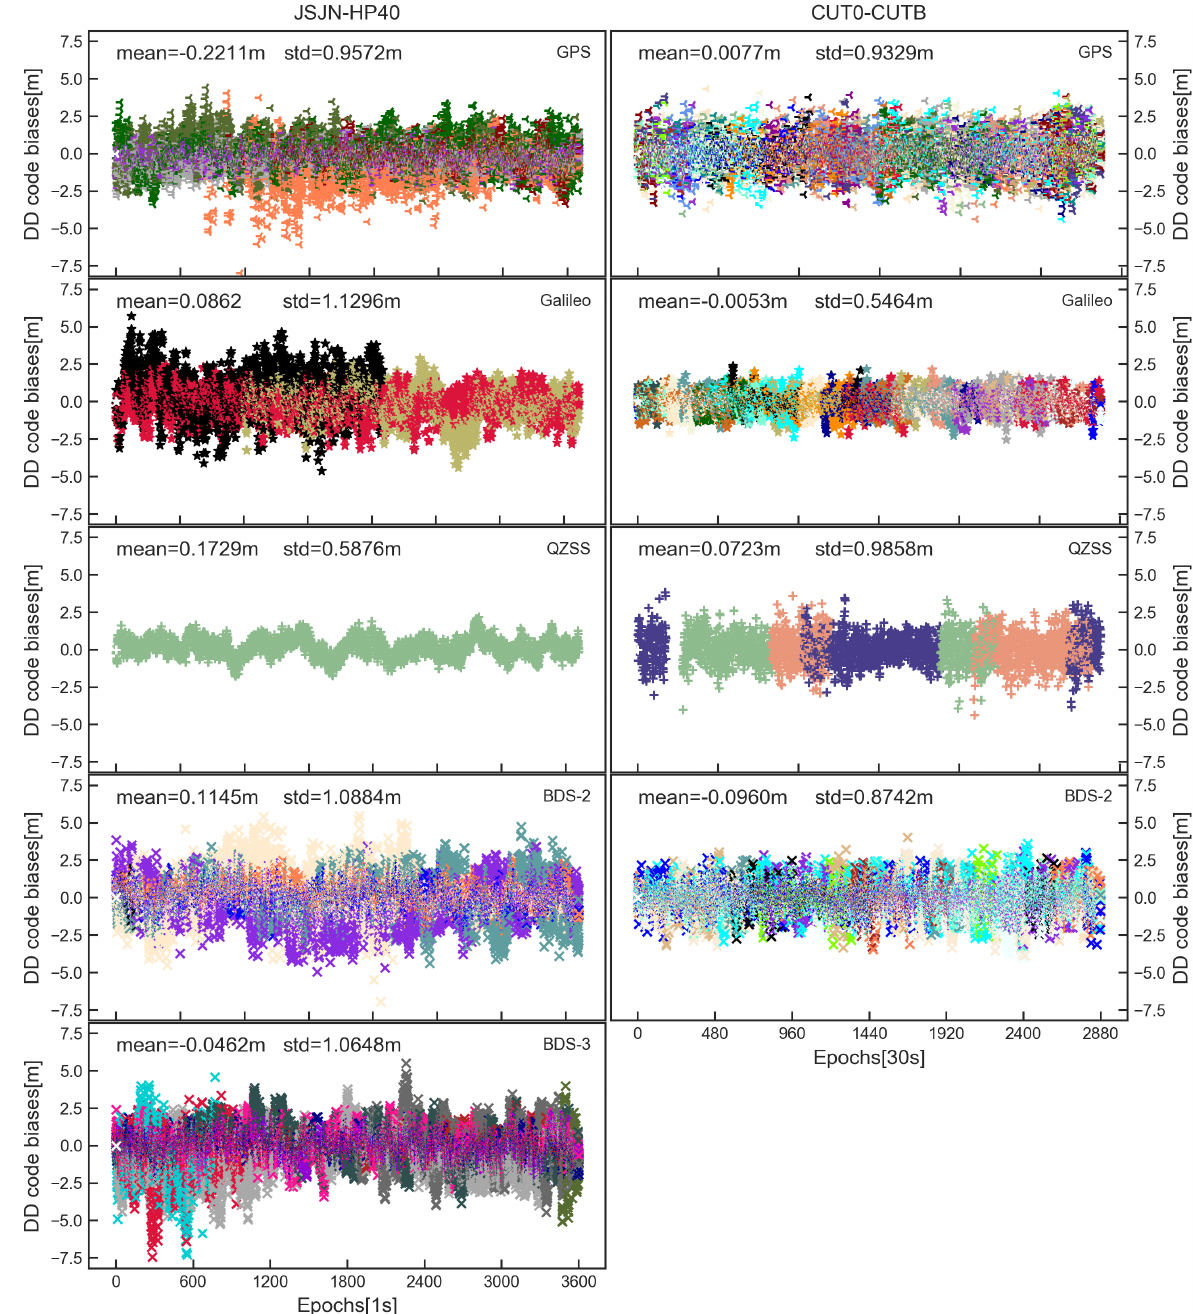
Figure 4. The DD receiver channel − dependent code bias (m) of different systems and satellites for JSJN − HP40 and CUT0 −